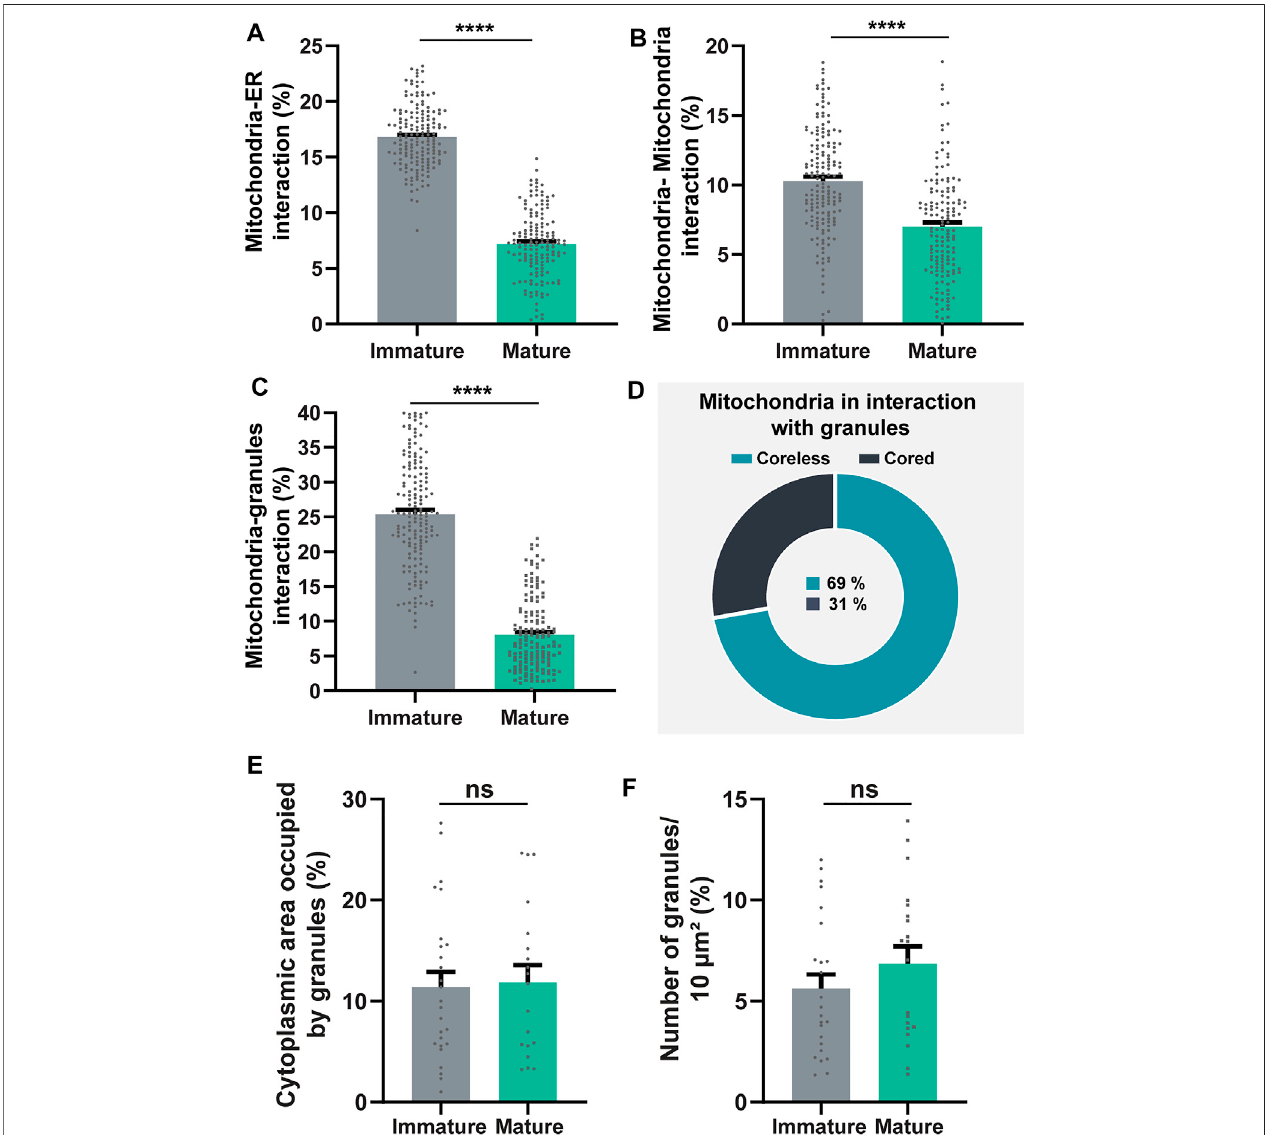
FIGURE 5 | Quantitative analyses of mitochondria inter-organelle interactions and granule distribution in the cytoplasm during mouse eosinophil development. (A – C) Mitochondria-ER, mitochondria-mitochondria, and mitochondria-granules associations (membrane contact sites) are signi fi cantly higher within immature comparedtomatureeosinophils. (D) Inimmatureeosinophils,mitochondriacontactpredominantlycorelessgranules. (E,F) Thecytoplasmicareaoccupiedbysecretory granules does not change in immature compared with mature eosinophils. Scattered dots in A-C represent single mitochondria while in E and F scattered dots represent single-cell sections. A total of 317 mitochondria (166 from immature and 151 from mature cells) and 875 granules (521 from immature and 354 from mature cells) were evaluated at high resolution in 48 eosinophils (28 immature and 20 mature) collected from at least three independent cell cultures. Results are expressed as means ± SEM (**** p < 0.0001; ns (not signi fi cant) p > 0.05).